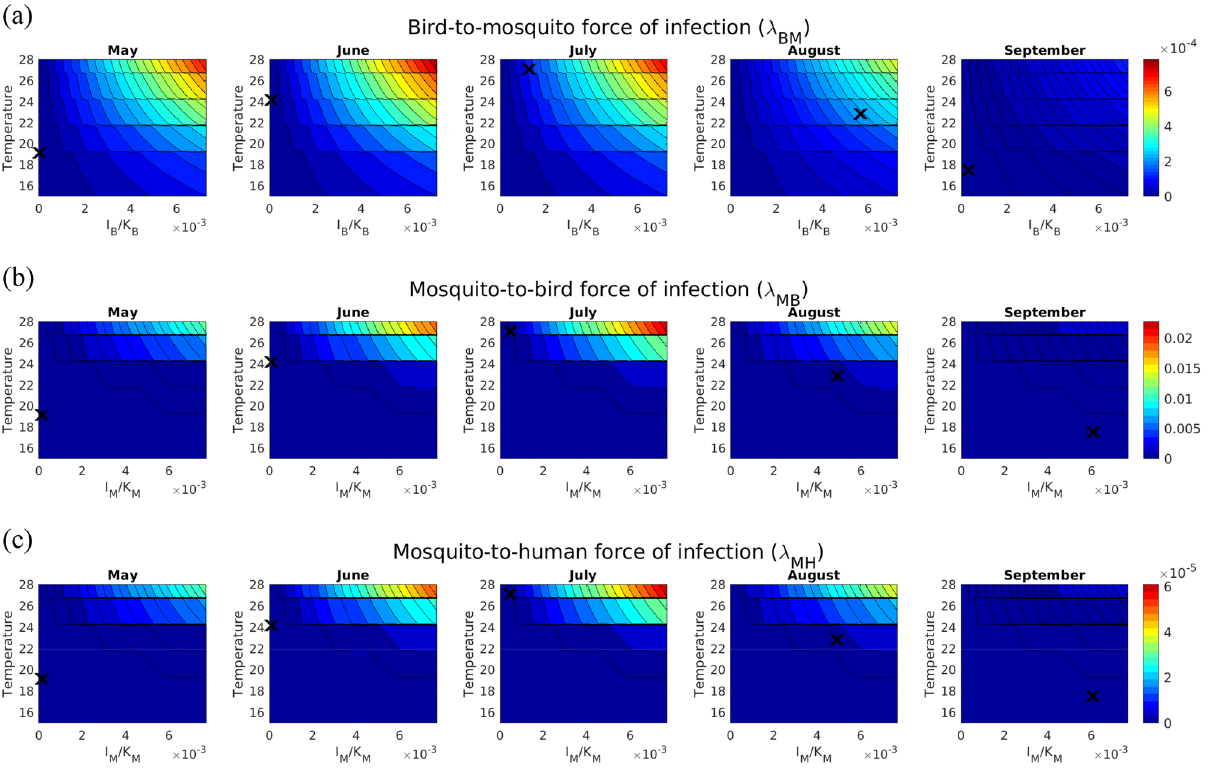
Figure 4. Contour plots of the forces of infection for May to September for different values of the relative abundance of infected hosts/vectors with respect to the carrying capacity and the temperature. All the other quantities were fixed to the amounts obtained in the simulations for Pellas municipality for 2021 at the end of the corresponding month. ( a ) Bird-to-mosquito force of infection ( (cid:31) BM ) as a function of the relative abundance of infected birds ( I B ) with respect to the bird carrying capacity ( K B ) and temperature. ( b ) Mosquito-to-bird force of infection ( (cid:31) MB ) as a function of the relative abundance of infected mosquitoes ( I M ) with respect to the mosquito carrying capacity ( K M ) and temperature. ( c ) Mosquito-to-human force of infection ( (cid:31) MH ) as a function of the relative abundance of infected mosquitoes ( I M ) with respect to the mosquito carrying capacity ( K M ) and temperature. The ranges for I B / K B and I M / K M were fixed, increasing the maximum modelled value by 20% for the considered period, while the range for the temperature was chosen considering that in the period of interest, the average daily temperature ranged from 16.6 to 27.1 degrees Celsius. Black crosses represent the modelled values for